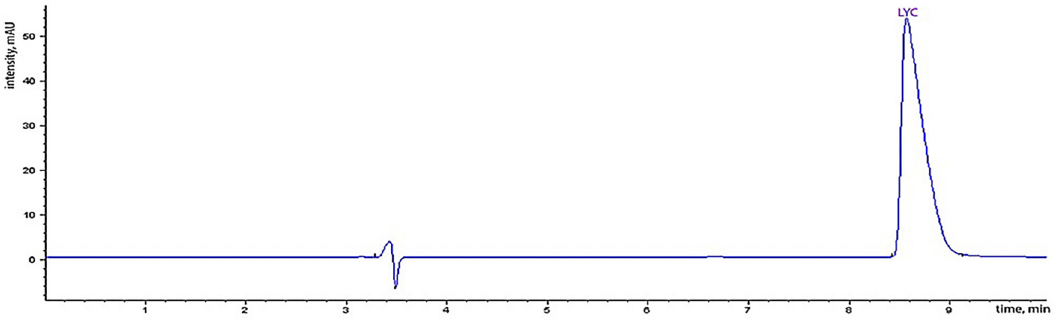
FIGURE 2 - Chromatogram of